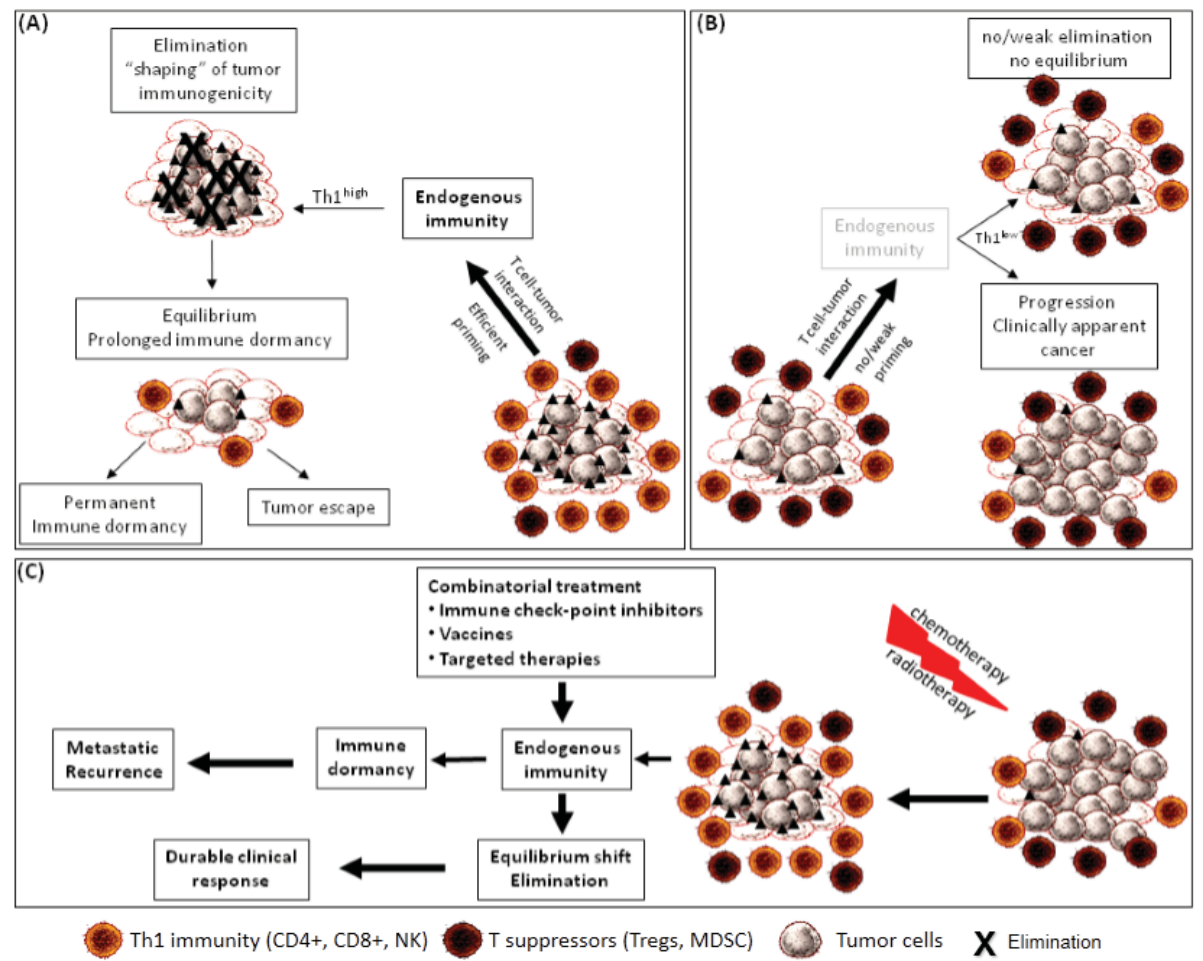
Figure 1. Endogenous immunity possesses a central role to tumor dormancy under an equilibrium condition with immunologic clearance. Endogenous immunity controls immunogenic tumor cells through the processes of elimination and equilibrium. Elimination functions as an extrinsic tumor suppressor in naïve hosts in which innate and adaptive immunity work together to detect and destroy immunogenic tumor cells before they become clinically symptomatic. Certain tumor variants may not be completely eliminated, but their net growth is restricted by immunity control, resulting in an equilibrium state and maintenance of tumor cells in prolonged dormancy. These DTC may induce a host-protective immune response and remain in permanent dormancy. Over a prolonged period, via immune adaptation and genomic instability, DTCs may enter into an attenuated immunogenic status or may acquire a suppressor phenotype and escape from immunesurveillance ( A ). By non-immunogenic tumors endogenous immunity is weak, allowing tumors to grow progressively in an immuno-suppressive tumor microenvironment and give clinically detectable cancers ( B ). Such tumors can be rendered immunogenic via conventional treatments, thus reinstating endogenous antitumor immunity ( C ); Tumor-oriented therapies or immunotherapies alone or combined with standard therapies may potentiate the endogenous immunity to induce durable clinical benefit. Filled triangles show molecules conferring immunogenicity to tumor cells (e.g., MHC, co-stimulatory and adhesion molecules, tum or antigens, DC maturation